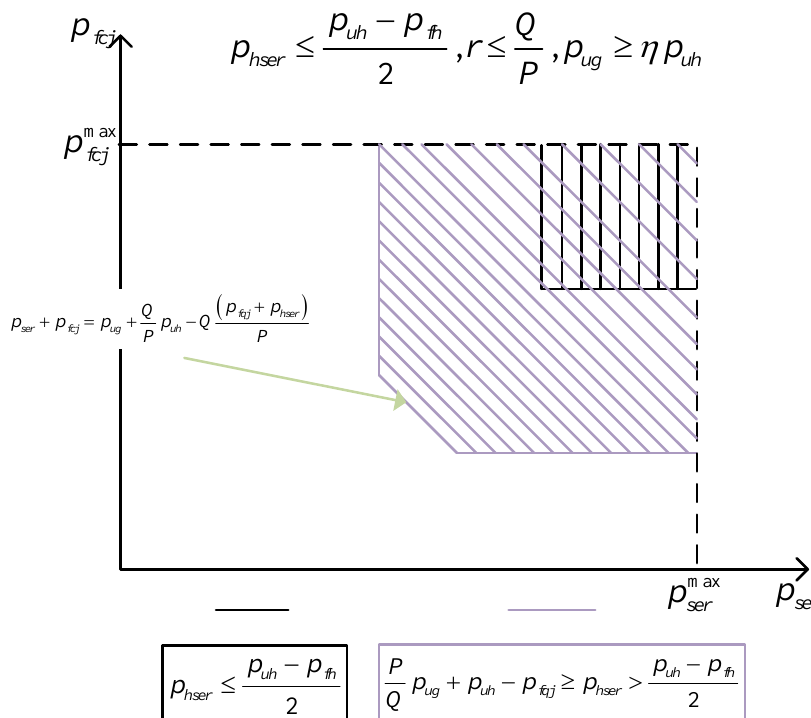
Figure A2. Scenarios 1,2: two-dimensional sketch of the tripartite game Nash equilibria.